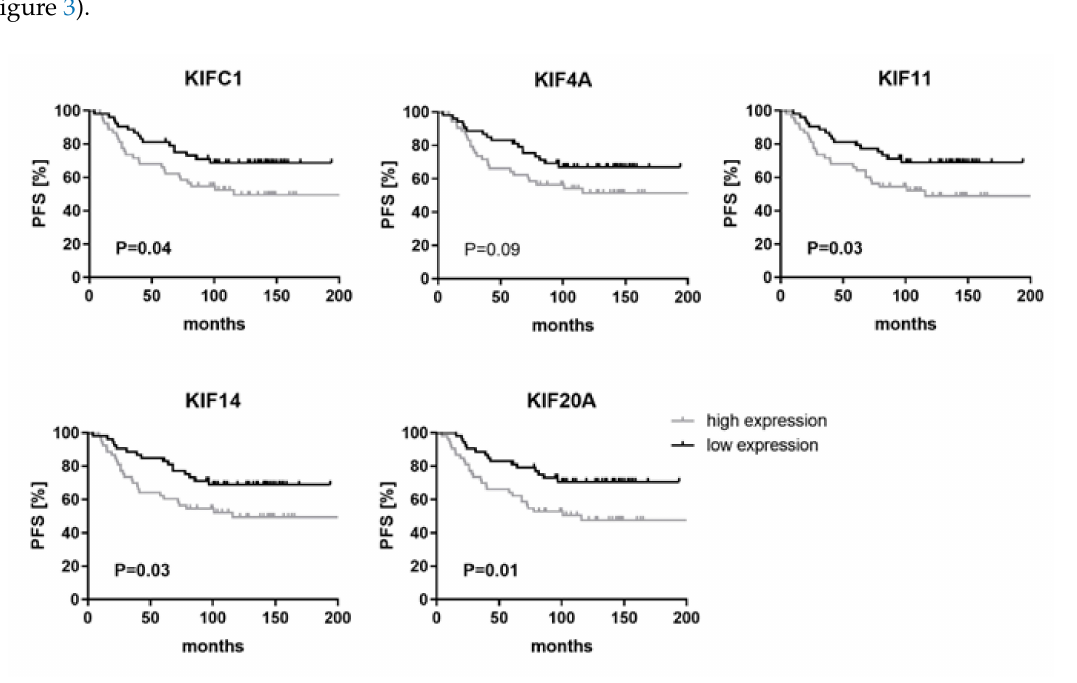
Figure 3. High mRNA expression levels of KIFC1, KIF11, KIF14 and KIF20A are associated with shorter progression-free survival. Kaplan–Meier plots show survival association of each investigated kinesin. The patients were categorized into two groups according to their median mRNA expression levels into high (grey curve) and low (black curve) expression. Only primary tumor samples and Simpson ◦ I–III resected tumors were included in this analysis ( n = 106). Prognostic significance was determined using Log-rank (Mantel–Cox) tests. PFS: Progression-free